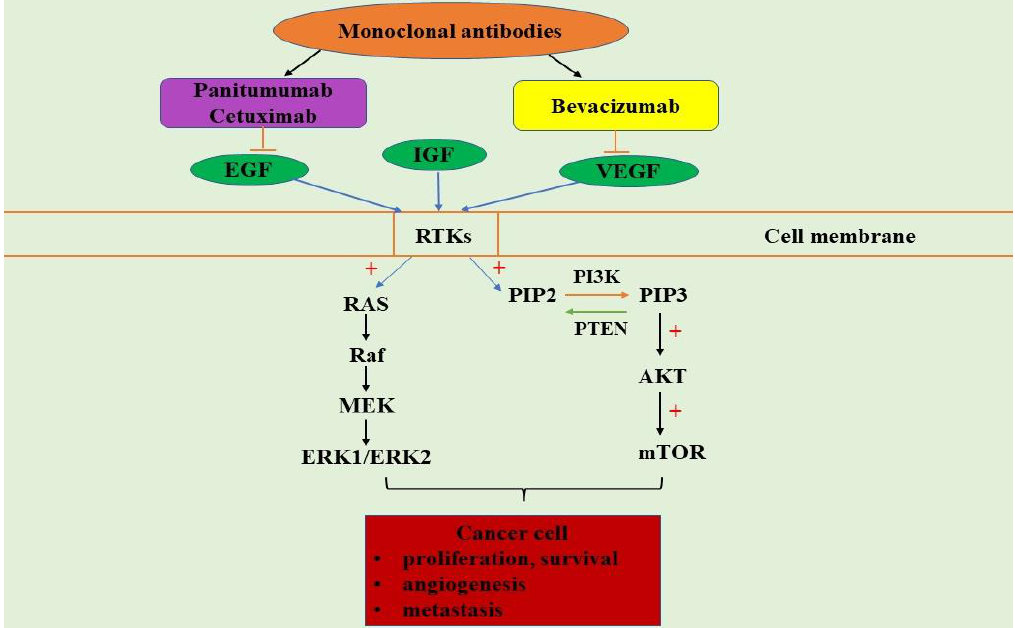
Figure 2. Growth factors, growth factor inhibitors, and PI3K/AKT/mTOR-MAPK signaling pathways in colorectal cancer development.